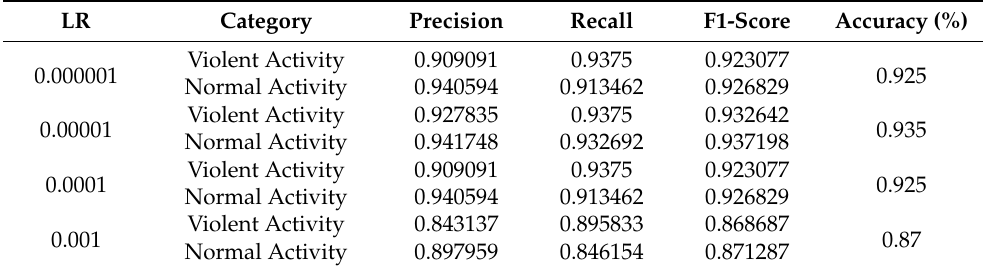
Table 8. Experimental result of the first sequential model on the Hockey Fight dataset.